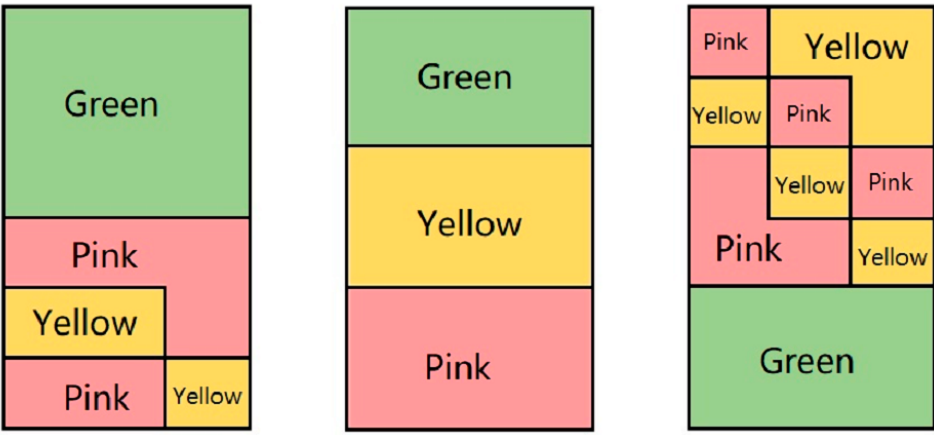
Figure 8. The priority domain distribution of the indoor sensor position when SWWR is equal to 0.3/0.5/0.7.